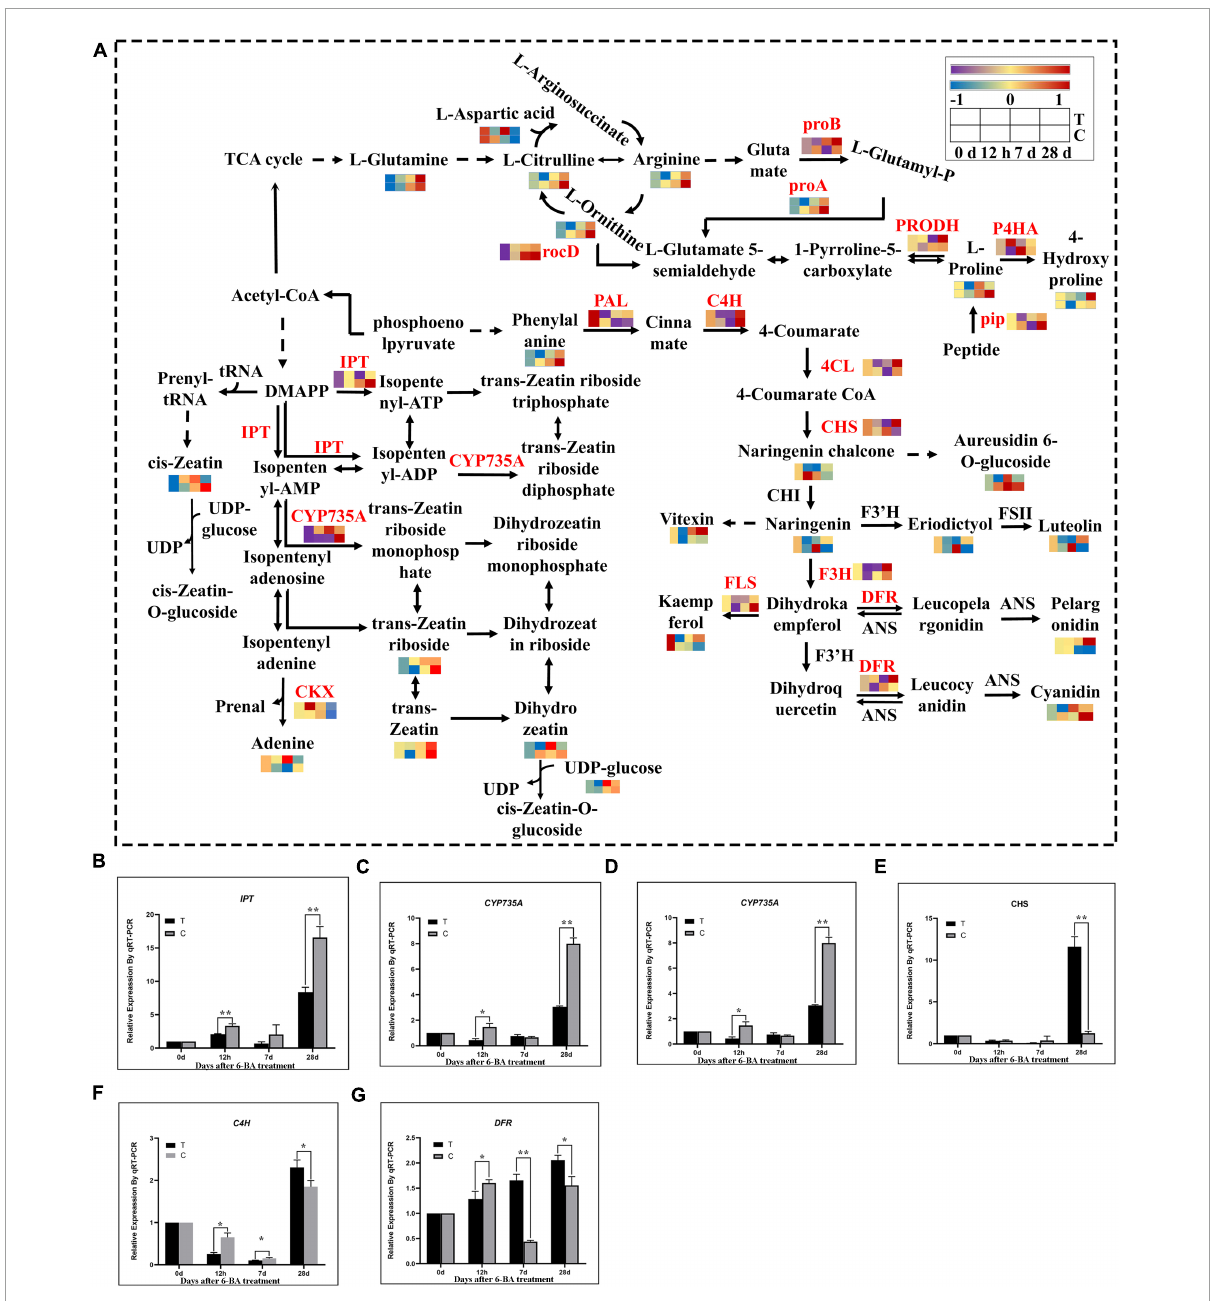
FIGURE4 Integrated transcriptomics and metabolomics analysis of flavonoid biosynthesis, arginine and proline metabolism, and zeatin biosynthetic pathways. (A) The DEGs and DEMs involved in the flavonoid biosynthesis, arginine and proline metabolism, and zeatin biosynthetic pathway at different stages. The color gradient, ranging from blue, through yellow, to red represents low, middle and high FPKM of genes. The color gradient, ranging from purple, through yellow, to red represents low, middle and high relative abundance of metabolites. T, Treatment group; C, Control group. (B–G) Verification of related genes in transcriptome by qRT-PCR. IPT , isopentenyl transferases gene; CYP735A , cytokinin hydroxylase gene; CKX , cytokinin degrading enzyme gene; CHS , chalcone synthase gene; C4H , cinnamate-4-hydroxylase; DFR , dihydroflavonol 4-reductase; “*” indicates that the difference is significant, “**” indicates that the difference is very